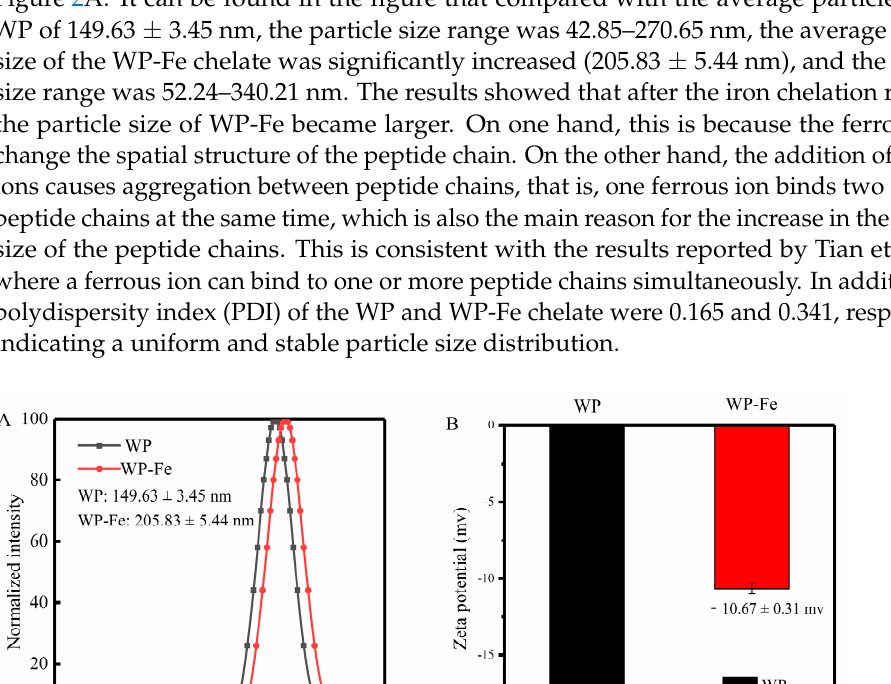
6 of 13 Figure 1. FTIR spectra of the WP and WP-Fe chelate. 3.3. Particle Size and Zeta Potential Analysis The particle size distribution curve is an important physical parameter for judging composite materials. The particle size distributions of WP and WP - Fe are shown in Figure 2A. It can be found in the figure that compared with the average particle size of WP of